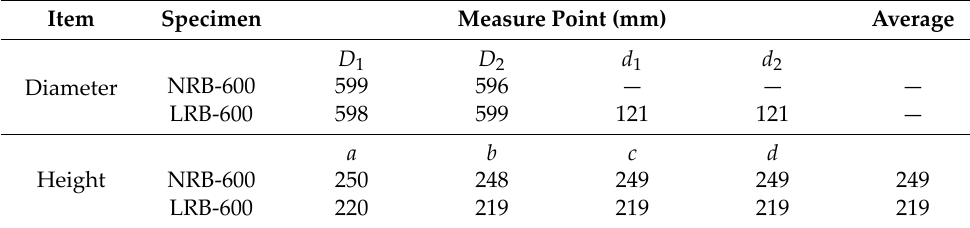
Table 2. Measured geometry of the specimens